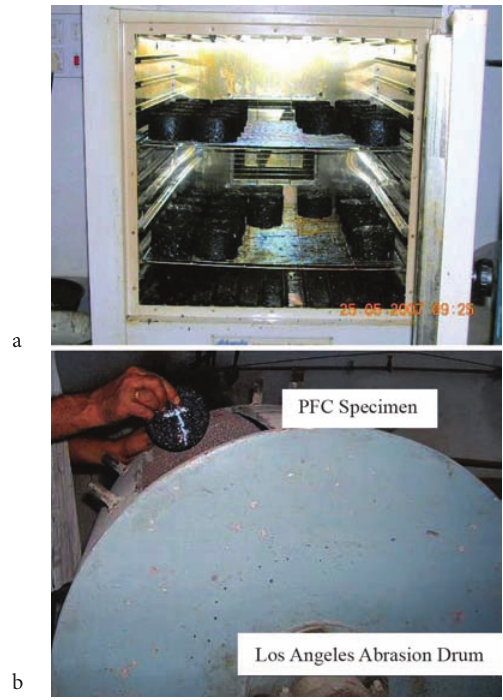
Fig. 6. Specimens subjected to aging in a hot air oven (a) and